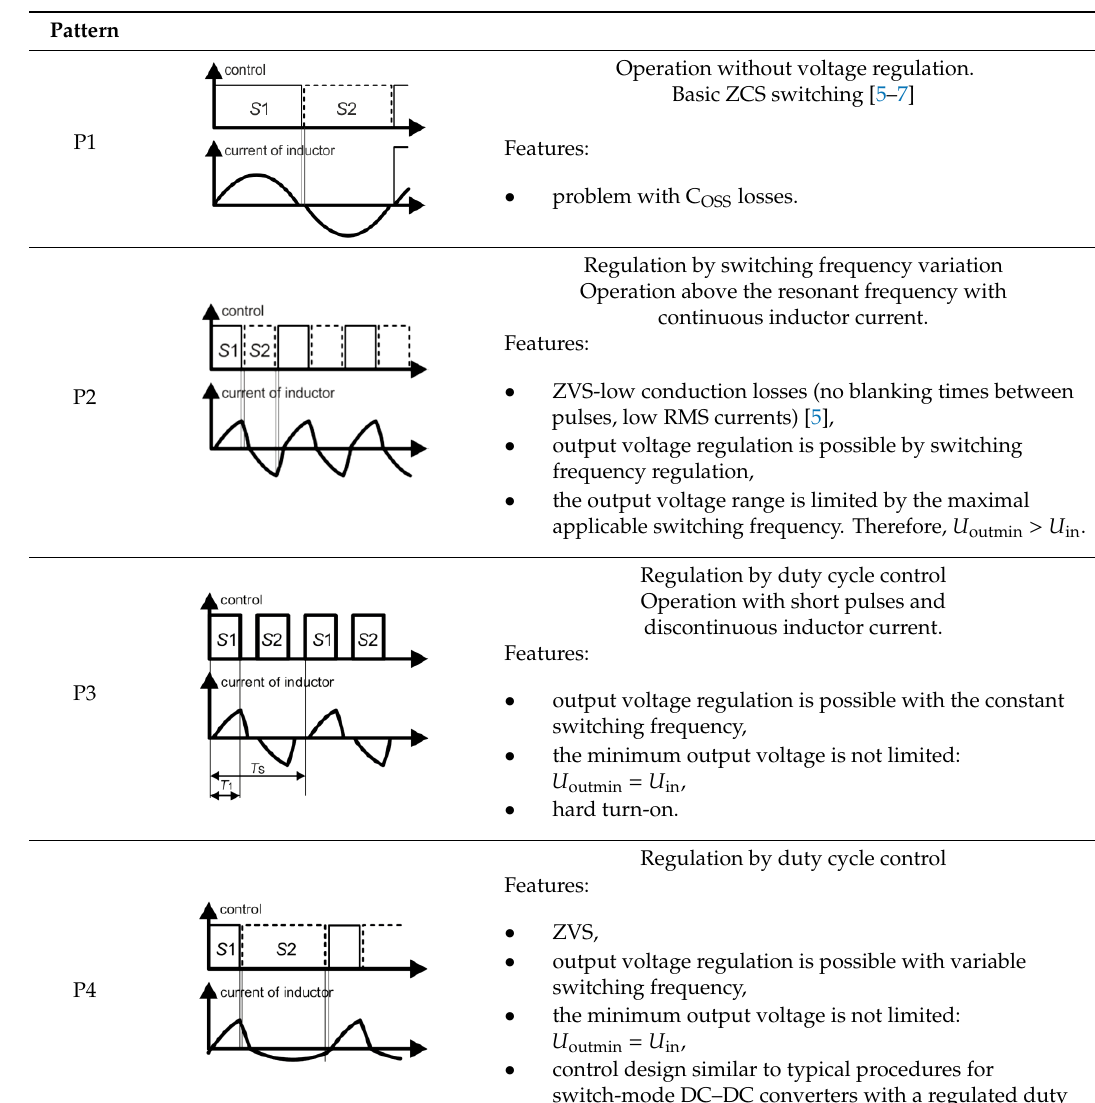
Table 1. Switching patterns of SCVD and their basic features.